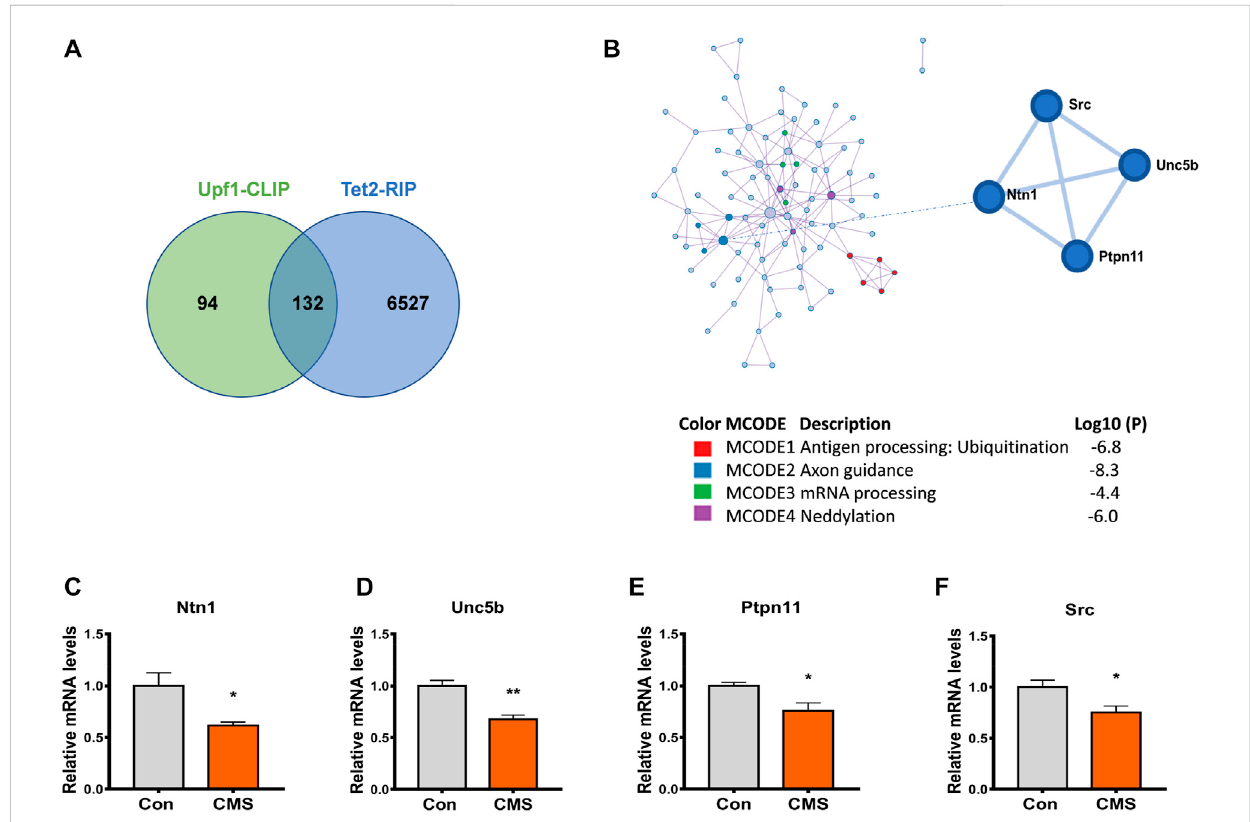
DownstreamgenesoftheTet2 – Upf1complexreducedinthehippocampusofstressedmice. (A) ScreeningofintersectiontargetgenesusingTet2- RIP and Upf1-CLIP data. (B) Screening of stress-related intersection target genes. (C – F) RT-PCR detection of the mRNA levels of target genes Ntn1 (* p